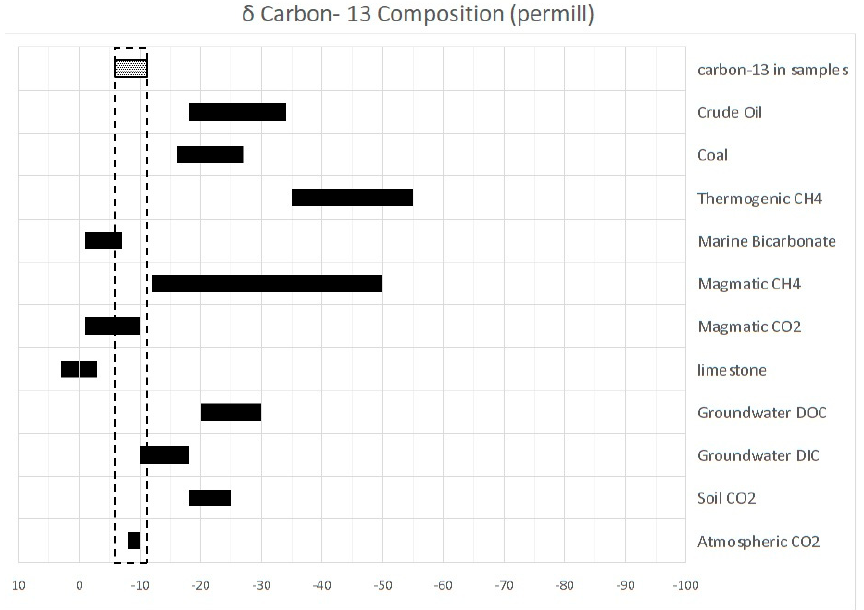
δ 13 C CO2 in thermal